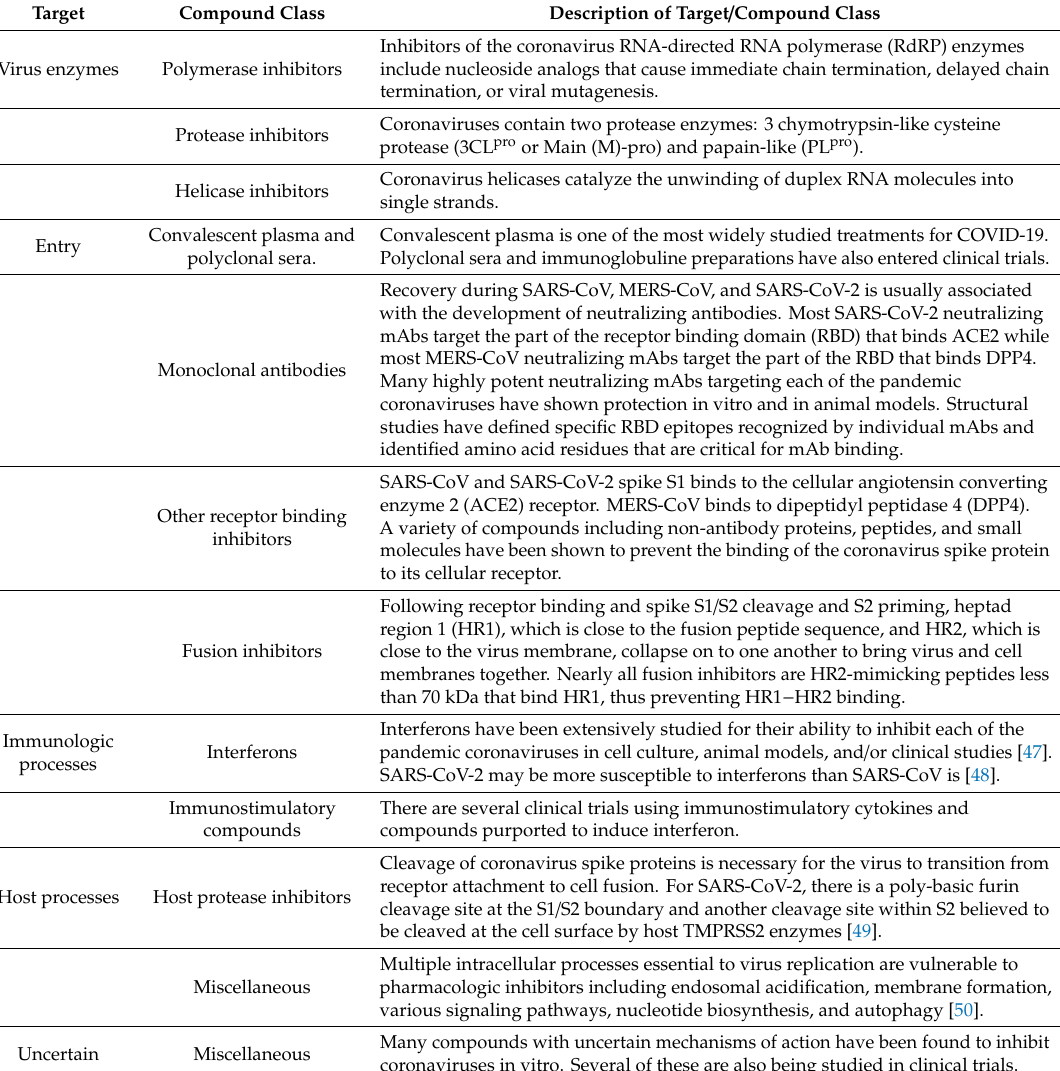
Table 3. Antiviral coronavirus therapy